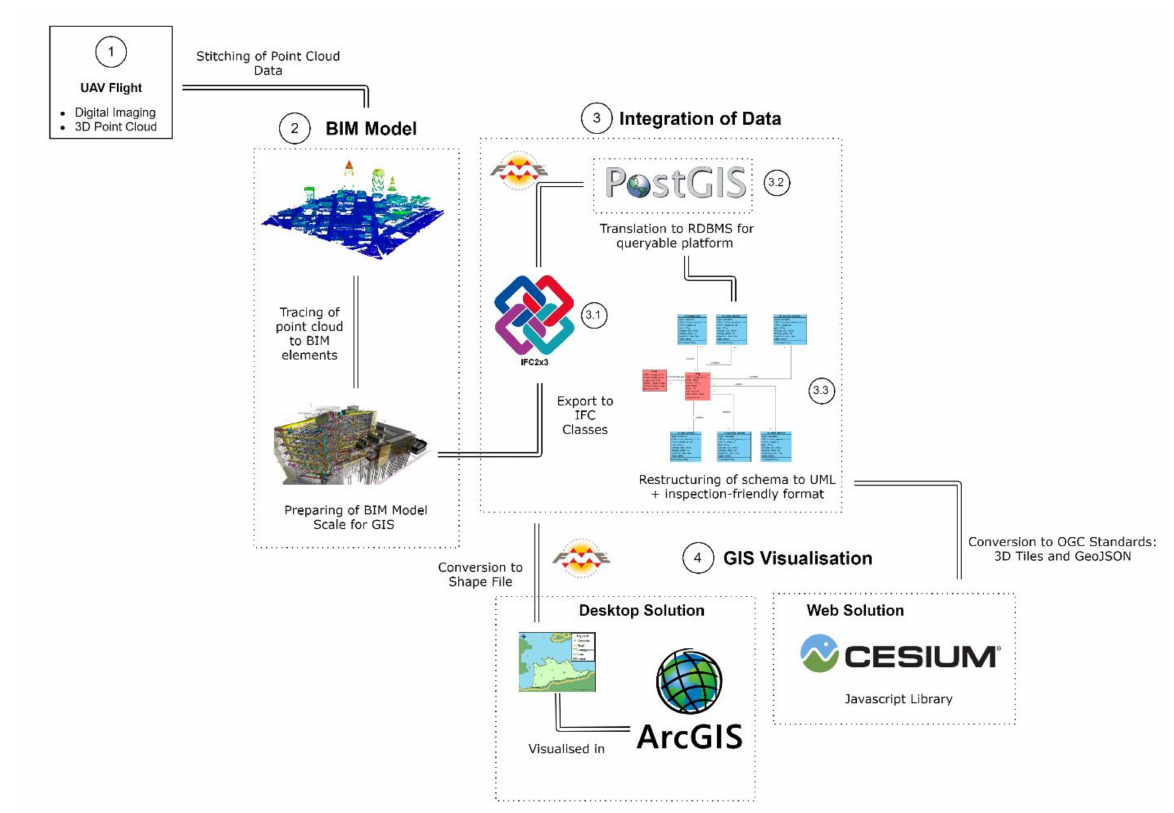
Figure 2. Proposed Network Architecture of Methodology.